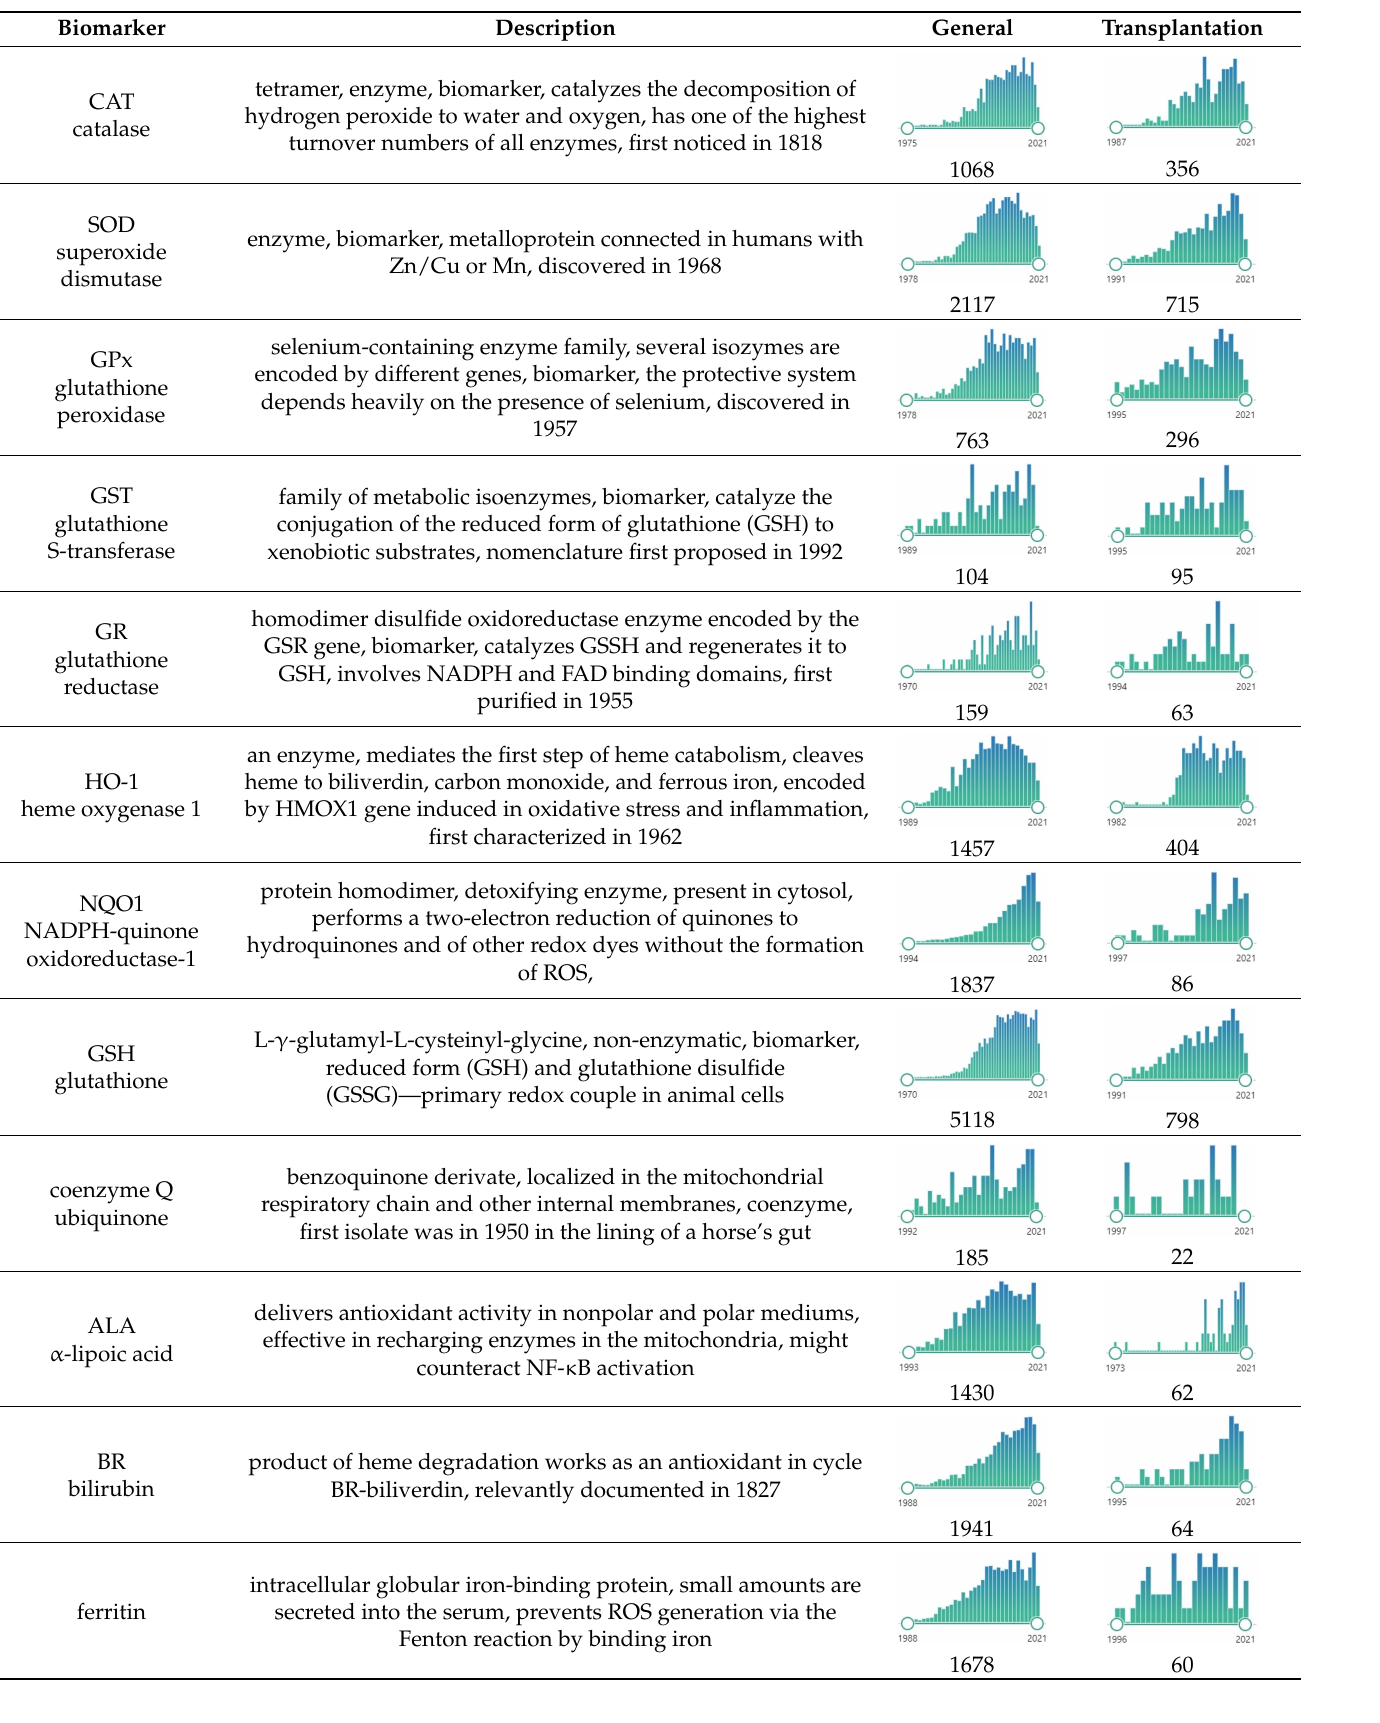
Table 2. Endogenous antioxidants—description and research